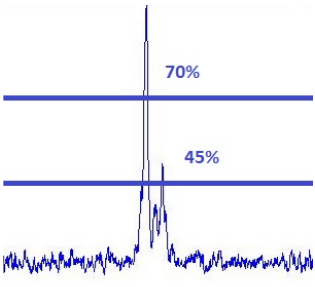
Figure 15. Example of channel response and the measure of the number of paths on the 70% and on the 45% threshold. The first one only detects one path, and the second one detects two paths. None of them detect the third small